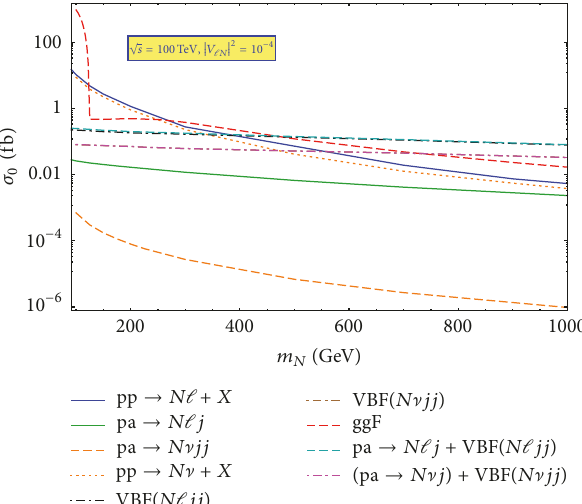
Figure11:ProductioncrosssectionsoftheRHNsinassociationwith leptons from different modes at the 13 TeV LHC with |𝑉 ℓ𝑁 | 2 = 10 −4 . “a” stands for photon (𝛾) as it is defined by MadGraph.